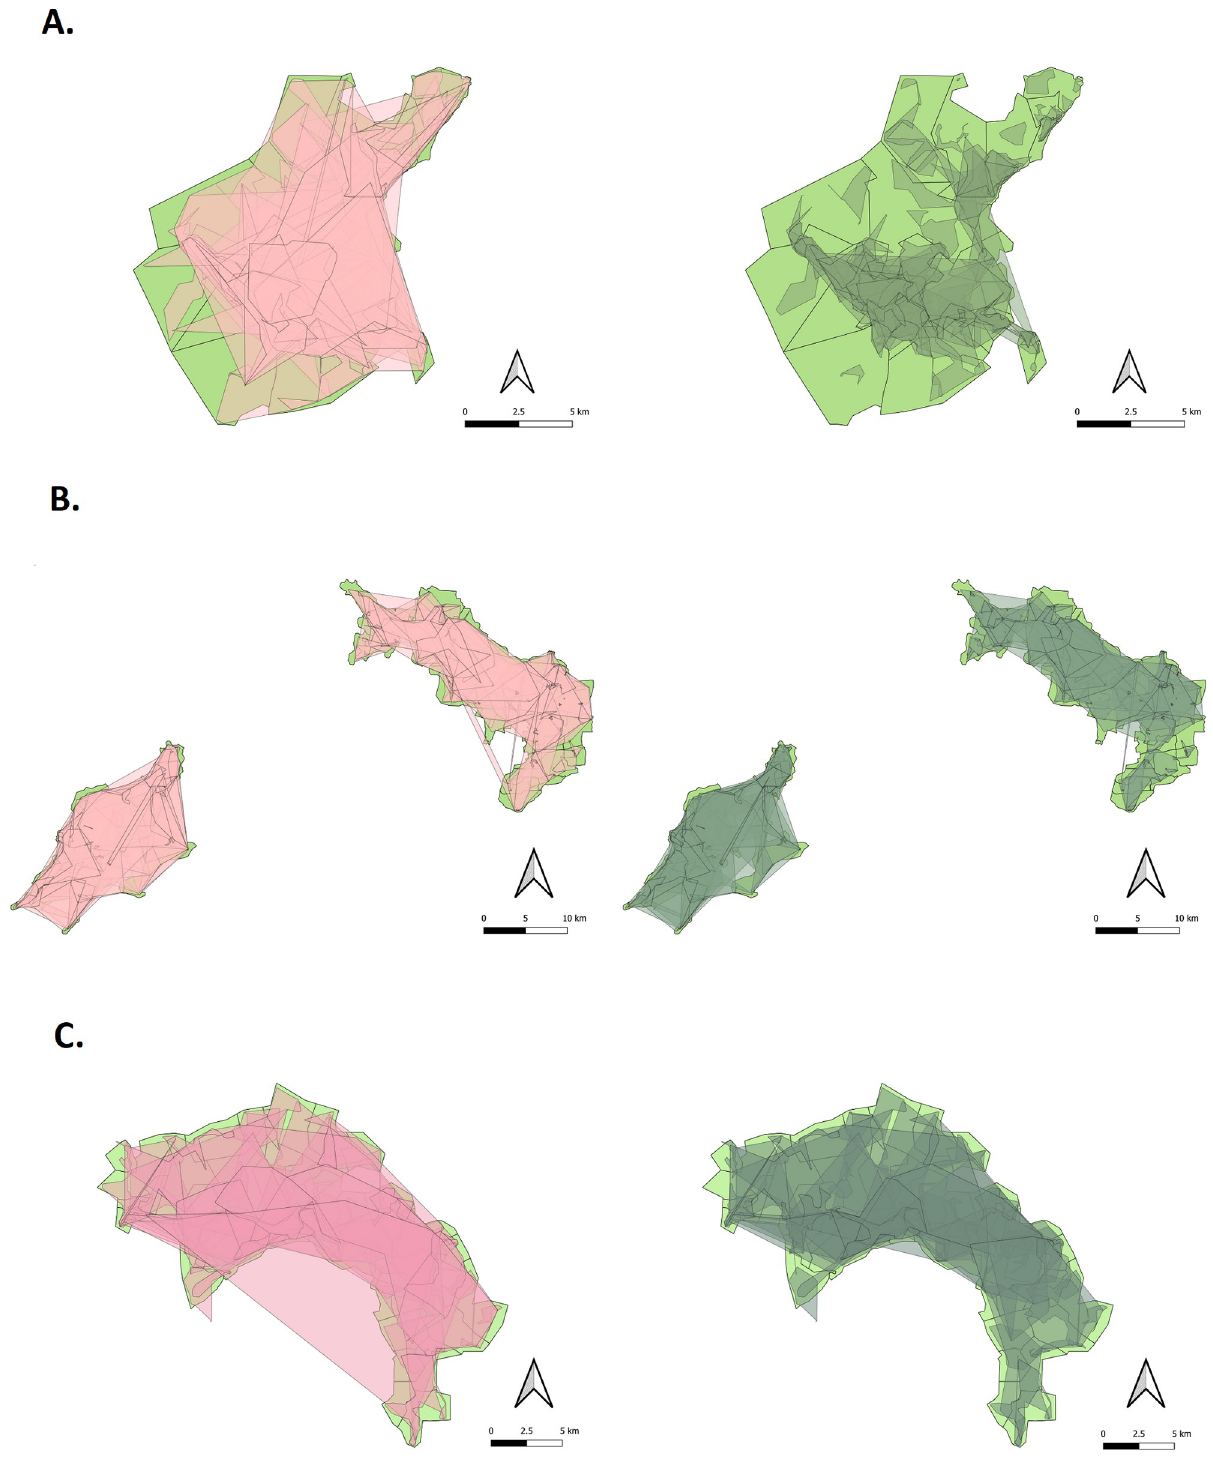
Fig 6. Catchment areas for each school by study area, created via QGIS Concave Hull (K-nearest neighbor) analysis. (A) Benin. (B) India. (C) Malawi. The left side of each panel shows na ï ve catchment areas in semi-transparent pink created prior to removal of geographic outliers, while the right side shows catchment areas in semi-transparent green created after removal of geographic outliers. Both overlay original cluster boundaries in green. Figures created using QGIS 3.10.7 A Coru ñ a.